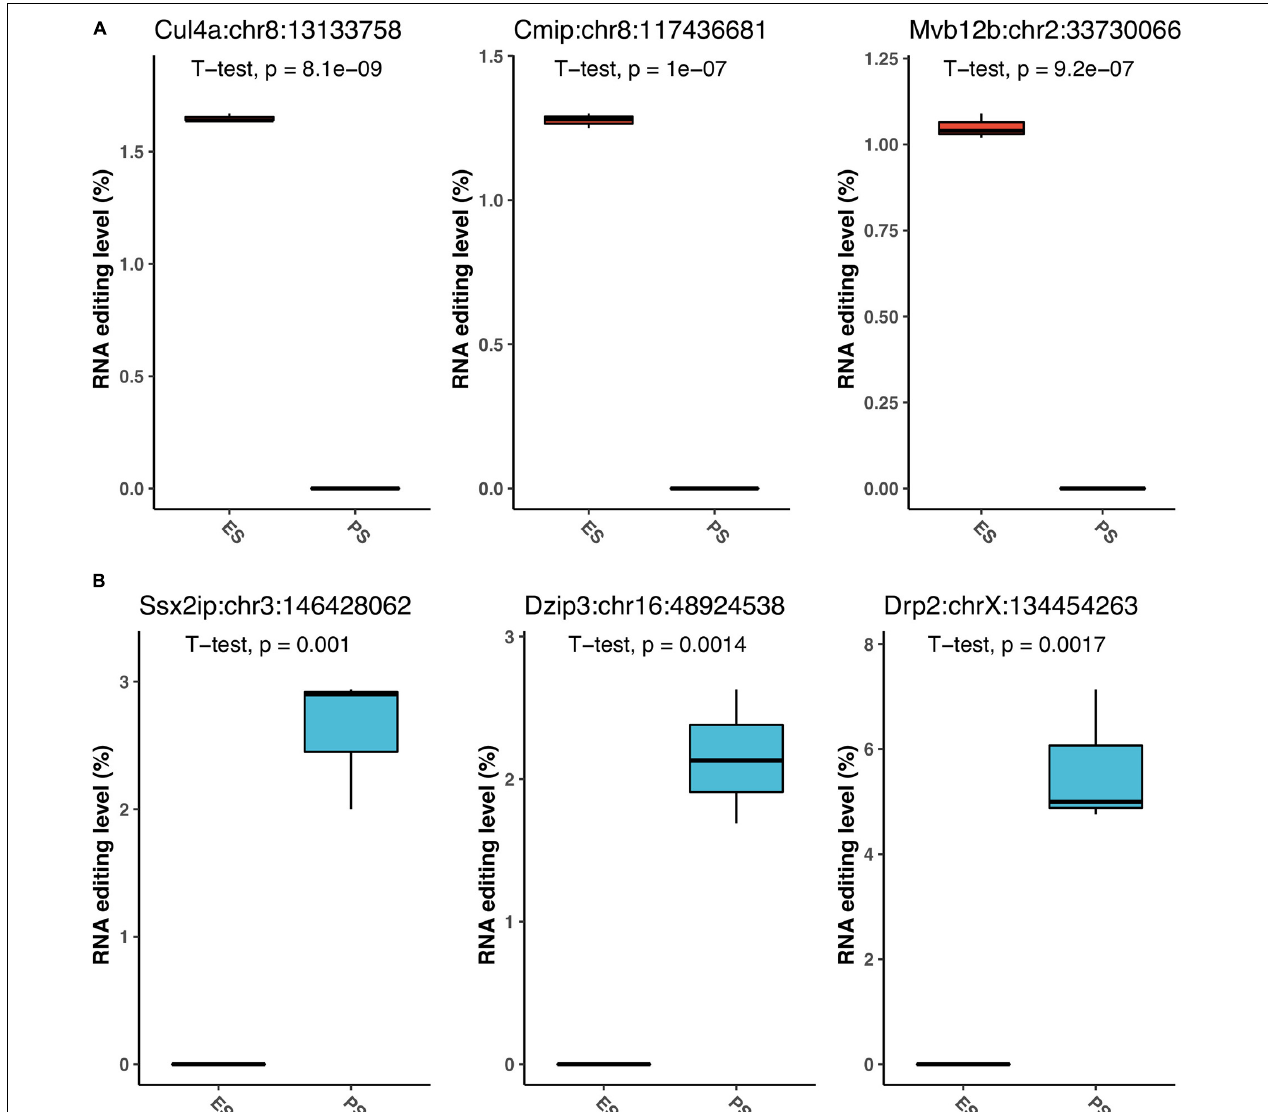
FIGURE 8 | The top G-to-A RNA editing with significant difference between PS and ES. The top three upregulated events in ES (A) , and top three downregulated events (B) in PS are